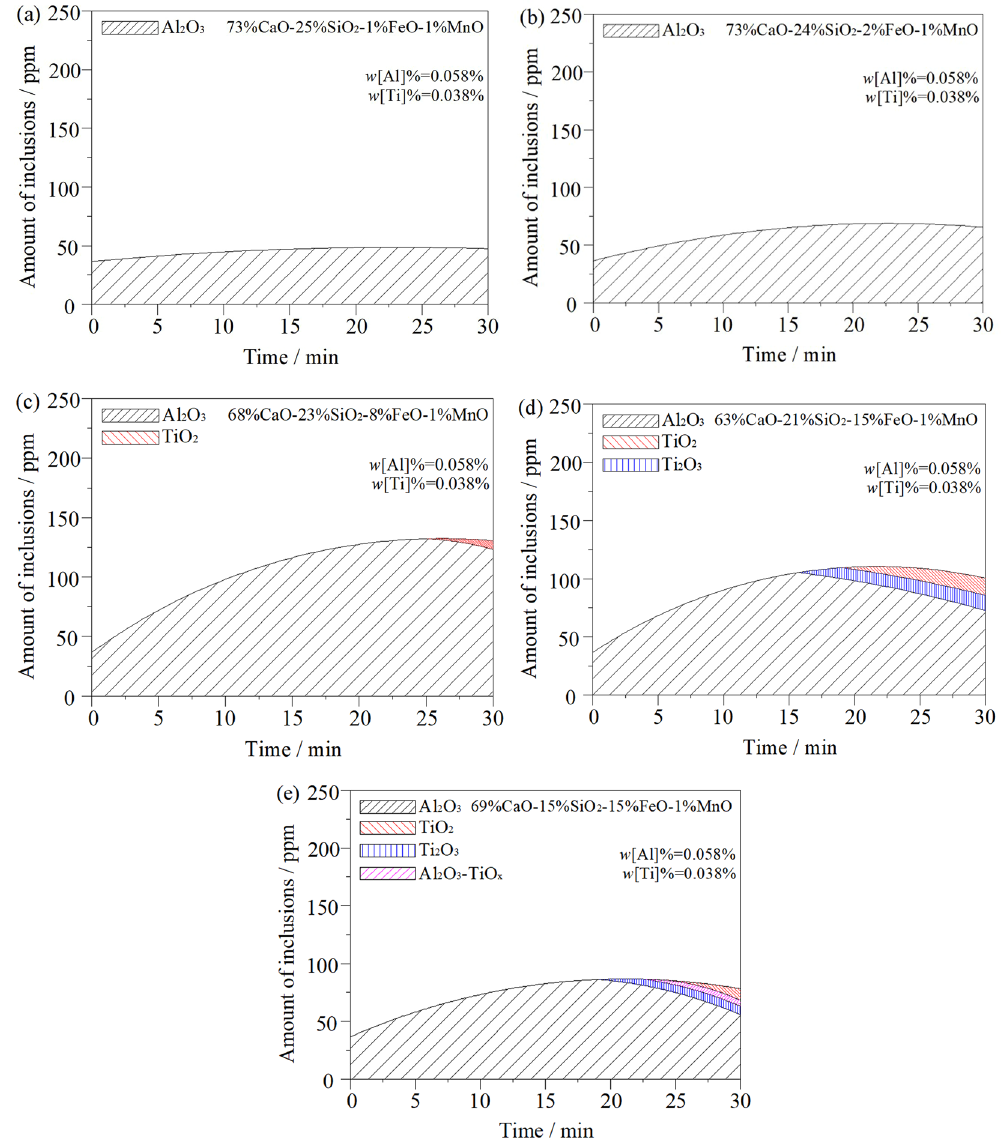
Figure 6. Effect of initial slag chemistry composition and basicity on change of inclusions in ultra-low carbon steel: ( a ) w (FeO)% = 1%, R = 3; ( b ) w (FeO)% = 2%, R = 3; ( c ) w (FeO)% = 8%, R = 3; ( d ) w (FeO)% = 15%, R = 3; ( e ) w (FeO)% = 15%, R =